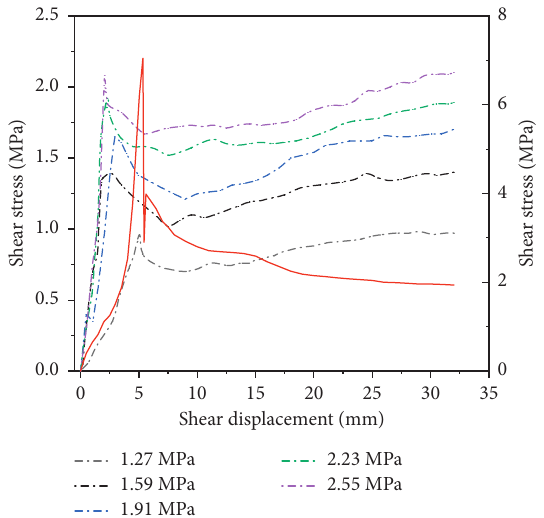
Figure 3: Curve of shear stress during shear